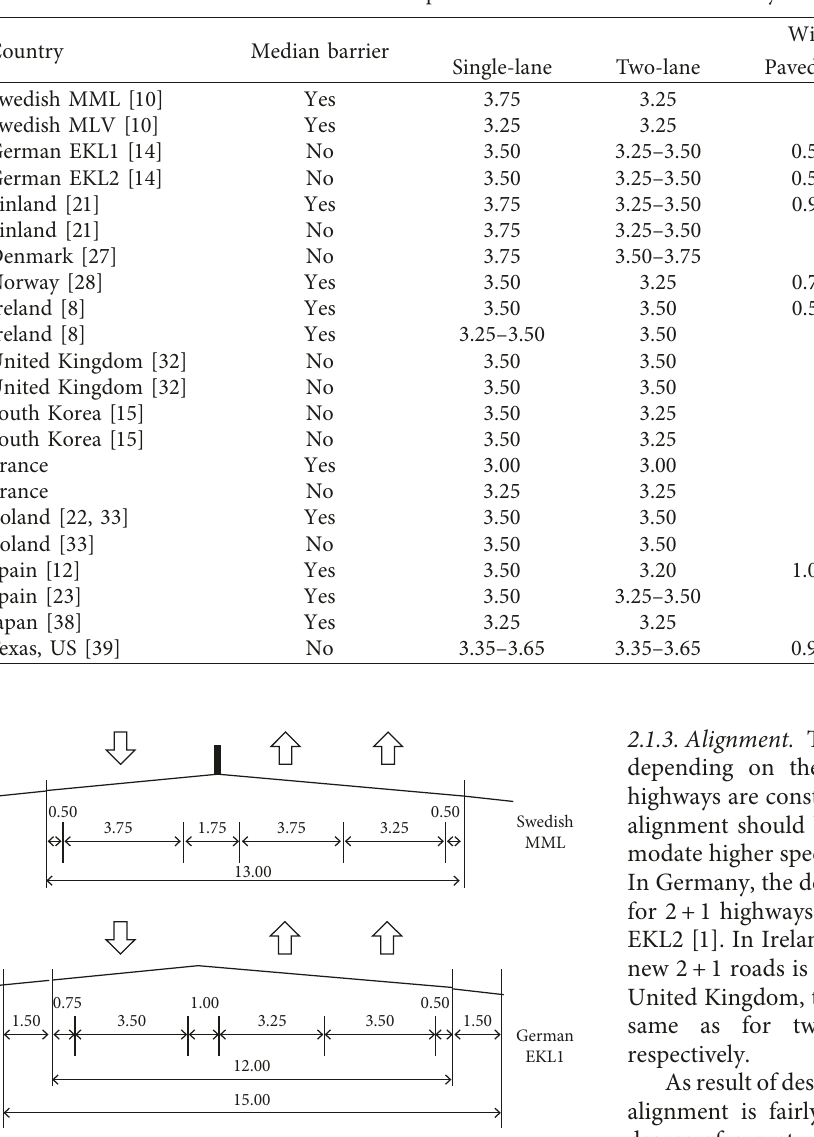
Figure 2: Typical cross sections of 2+1 highways in Swedish MML [10] and German EKL1